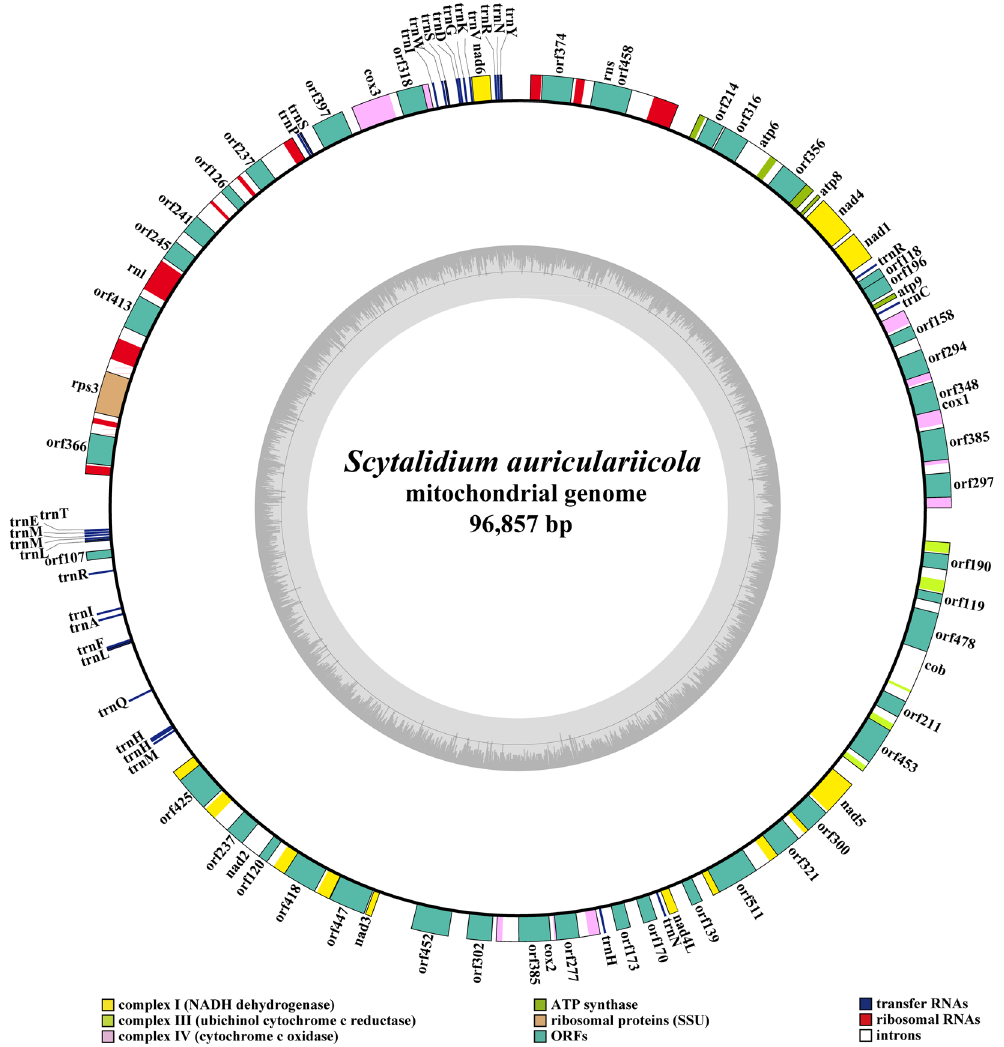
Figure 1. Circular map of the Scytalidium auriculariicola mitochondrial genome. Various genes are represented with different color blocks. The mitochondrial circular map was drawn using the OGDRAW software 58